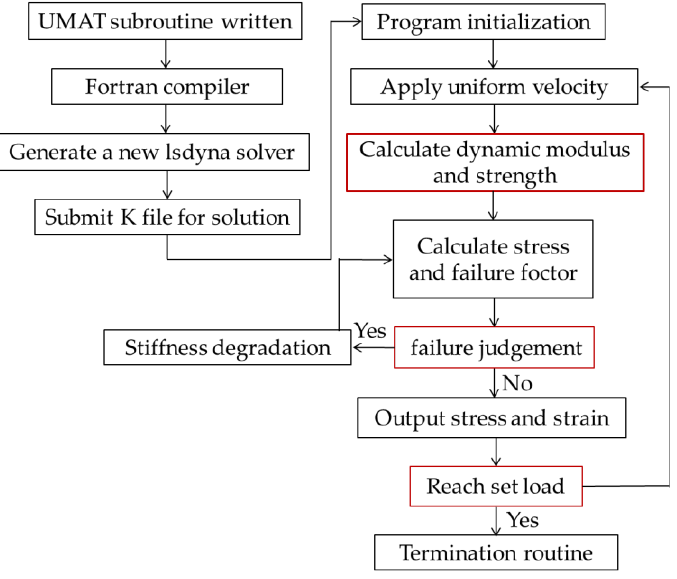
Figure 2. Flowchart of the subroutine calculation.